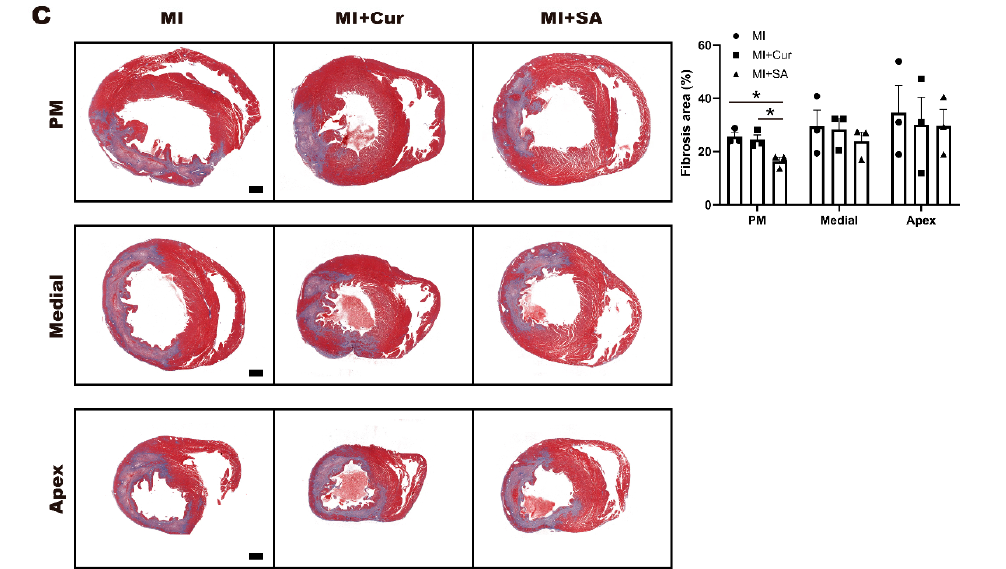
Figure 3. Histopathological images and results in each left ventricle area on day 4 after MI surgery. Representative photomicrographs are shown in hematoxylin and eosin and incidence of histopathologicalchanges( A , × 12.5)andrepresentativeH&Ephotomicrographswithhighmagnification ( B , × 40, × 400, × 1500). Mature lymphocyte (arrows) and mononuclear cells (arrow heads) are shown in myocardial region (Top, × 400) and mononuclear cells (arrow heads) with purulent (asterisk) are shown in endocardial region (Bottom, × 400). Representative cell image of lymphocyte (arrow) and mononuclear cell (arrow head) can be identified with high magnification ( × 1500). Representative photomicrographs in Masson’s trichrome and fibrosis area percentage ( C , × 12.5). * p < 0.05, indicate statistically significant di ff erences by one-way ANOVA with Tukey’s post hoc correction. Grading of histopathological changes in each tissue area (papillary muscle, medial, and apex) of the rat left ventricle. Grades 1, 2, 3, and 4 show minimal, slight, moderate, and severe pathological changes, respectively. Values are mean ± standard error of the mean (SEM, n =